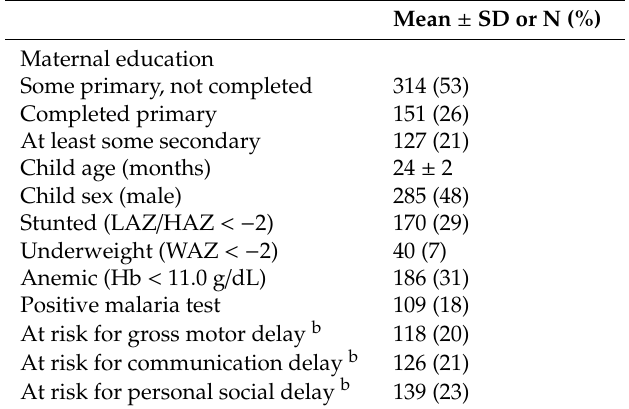
Table 1. Socio-demographic and child health characteristics of the study population ( n = 592) a .